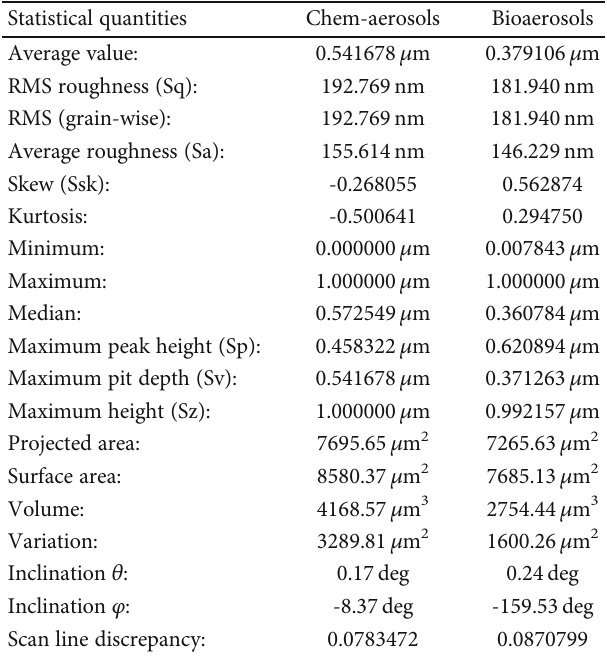
Table 2: SEM image